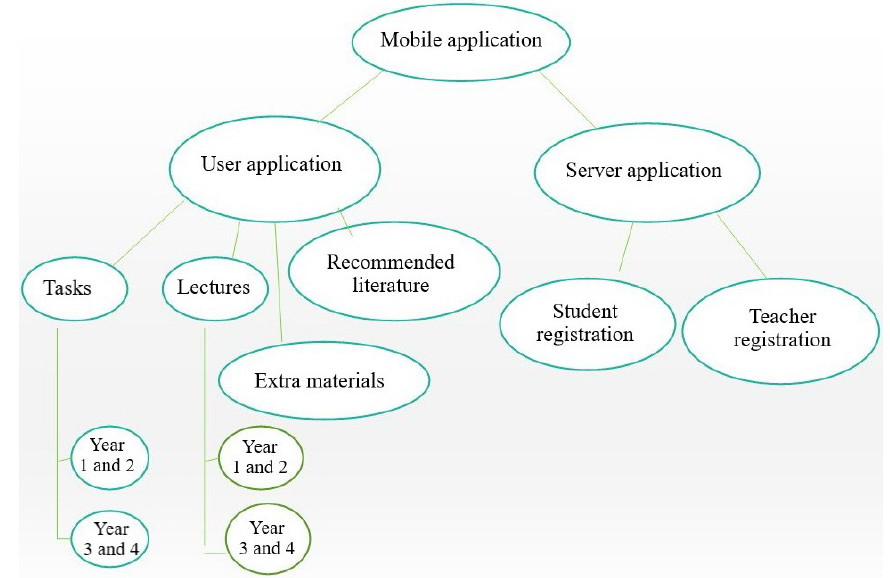
Fig. 1. The approximate structure of a mobile